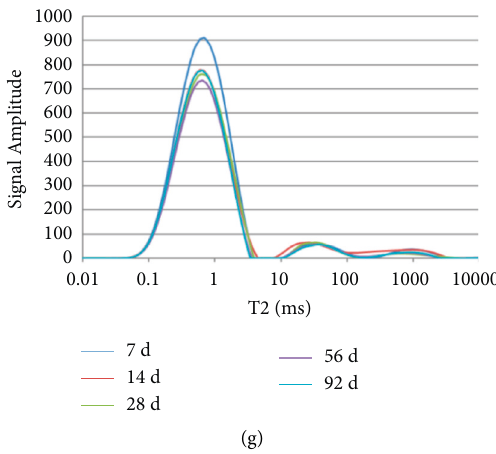
Figure 8: Relaxation image of N1 ∼ N7. (a) N1. (b) N2. (c) N3. (d) N4. (e) N5. (f) N6. (g) N7.